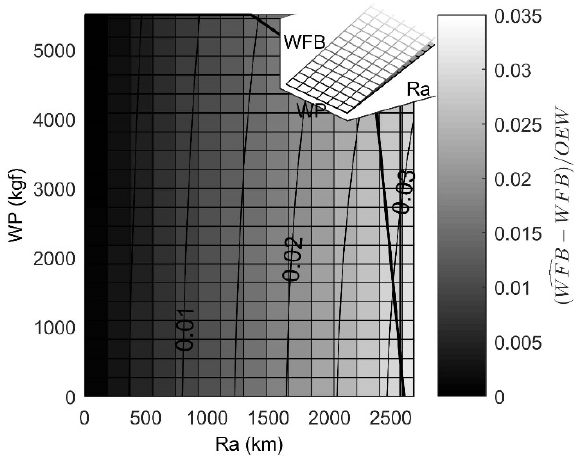
Figure 9. Relative error on the fuel consumption between the model estimate ˆWFB and the actual value WFB in the maximum constant altitude assumption for a validation sample. The thumbnail shows the actual unbracketed WFB surface in grey tones and the estimate ˆWFB-surface in shade.